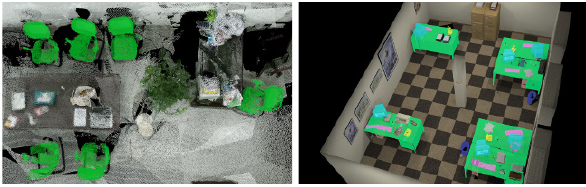
Fig. 8 Results of finding similar objects (shown in the same